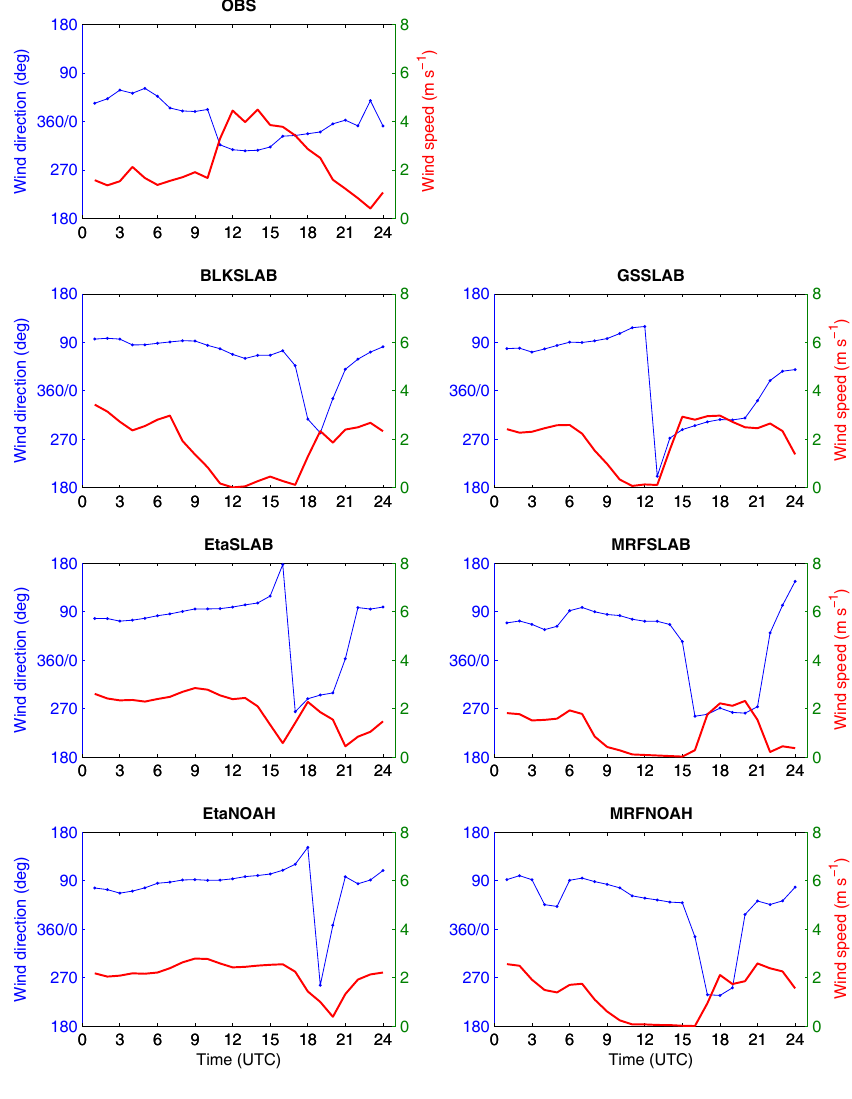
Fig. 6. Same as Fig. 2 but at GVC